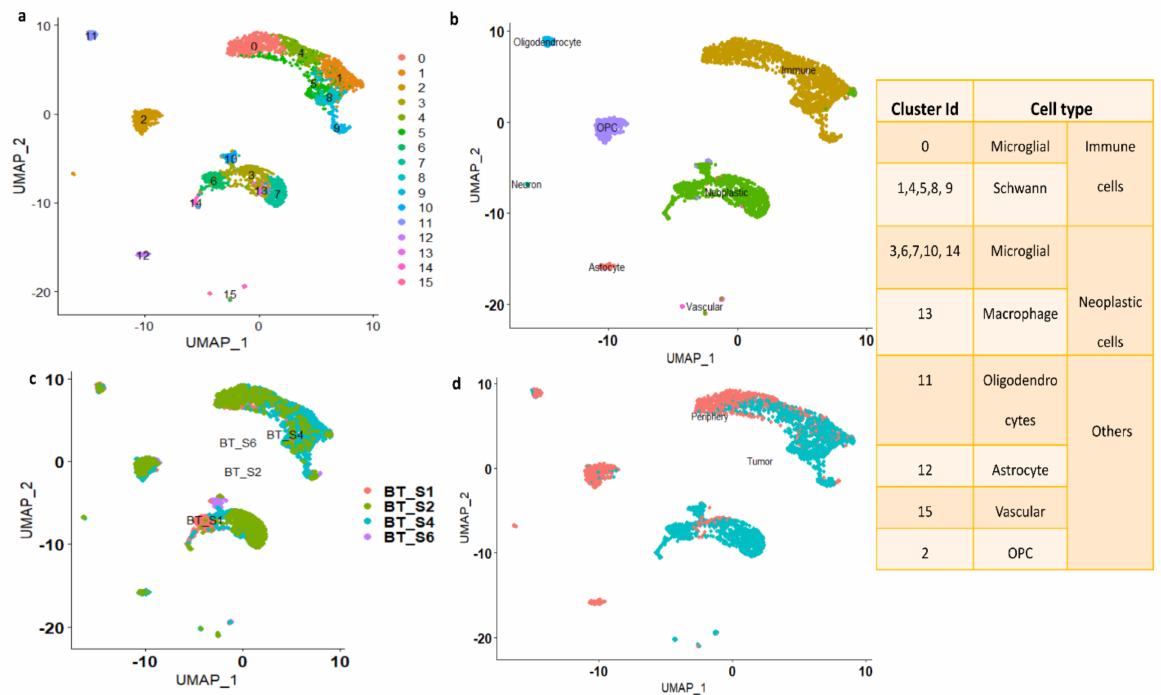
Figure 2. ( a ) UMAP plot showing the distribution of cells with cluster ID. ( b ) UMAP clusters are labeled based on major cell types. ( c ) Clustering of the cells based on patient-ID. ( d ) Clustering of the cells based on tissue. The table displays the cluster ID matches with cell